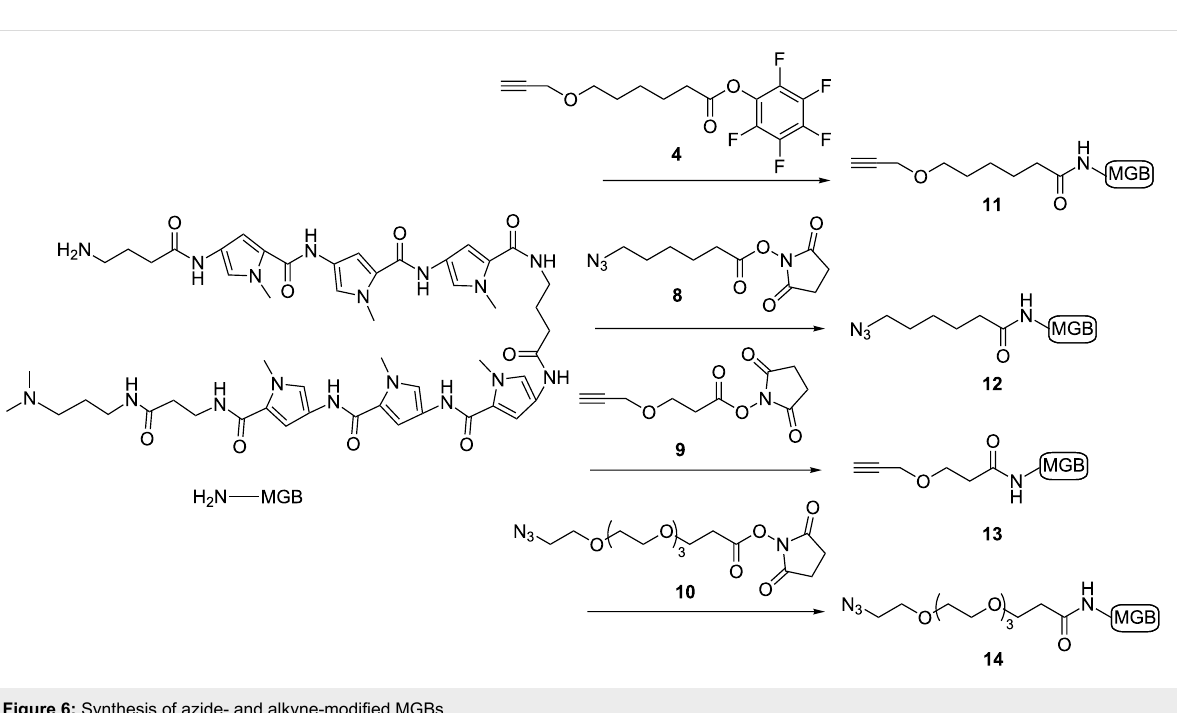
Figure 6: Synthesis of azide- and alkyne-modified